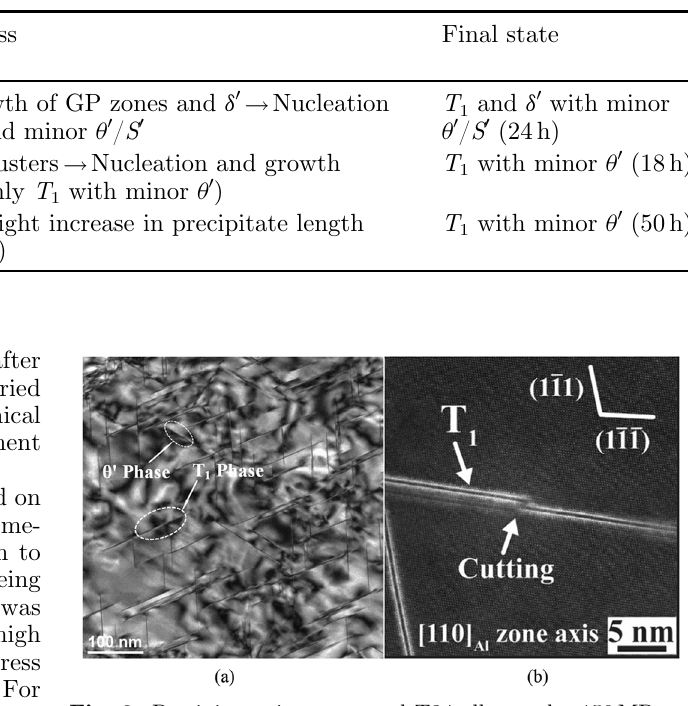
Fig. 3. Precipitates in creep-aged T34 alloy under 150MPa at 155 ° C for 18 h: (a) TEM image showing the T 1 and u 0 precipitate [6] and (b) HR-TEM image showing shearing (cutting) of the single layer T 1 precipitate